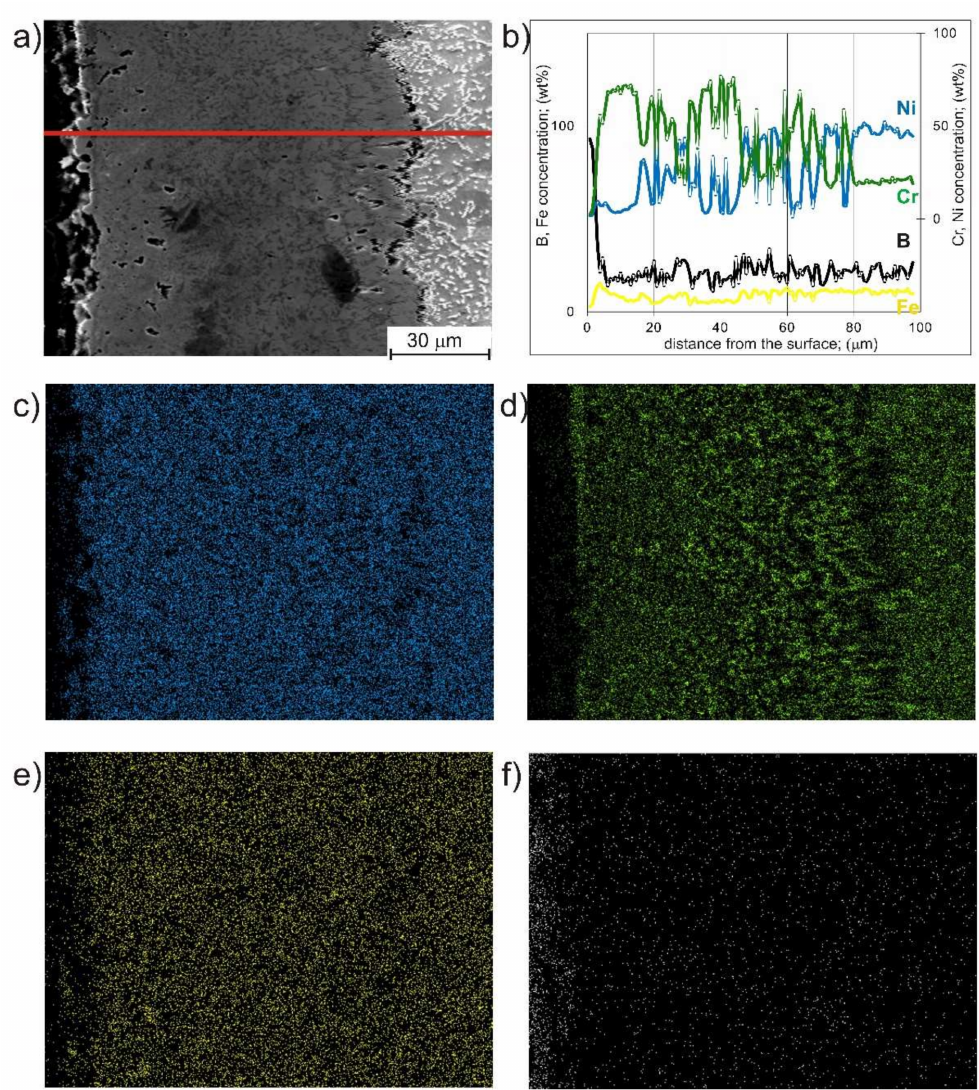
Figure 4. SEM microstructure of the gas-borided Inconel 600-alloy with a marked line along which EDS microanalysis was performed ( a ), the results of the linear EDS microanalysis ( b ) and the EDS maps obtained for nickel ( c ), chromium ( d ) iron ( e ) and boron ( f